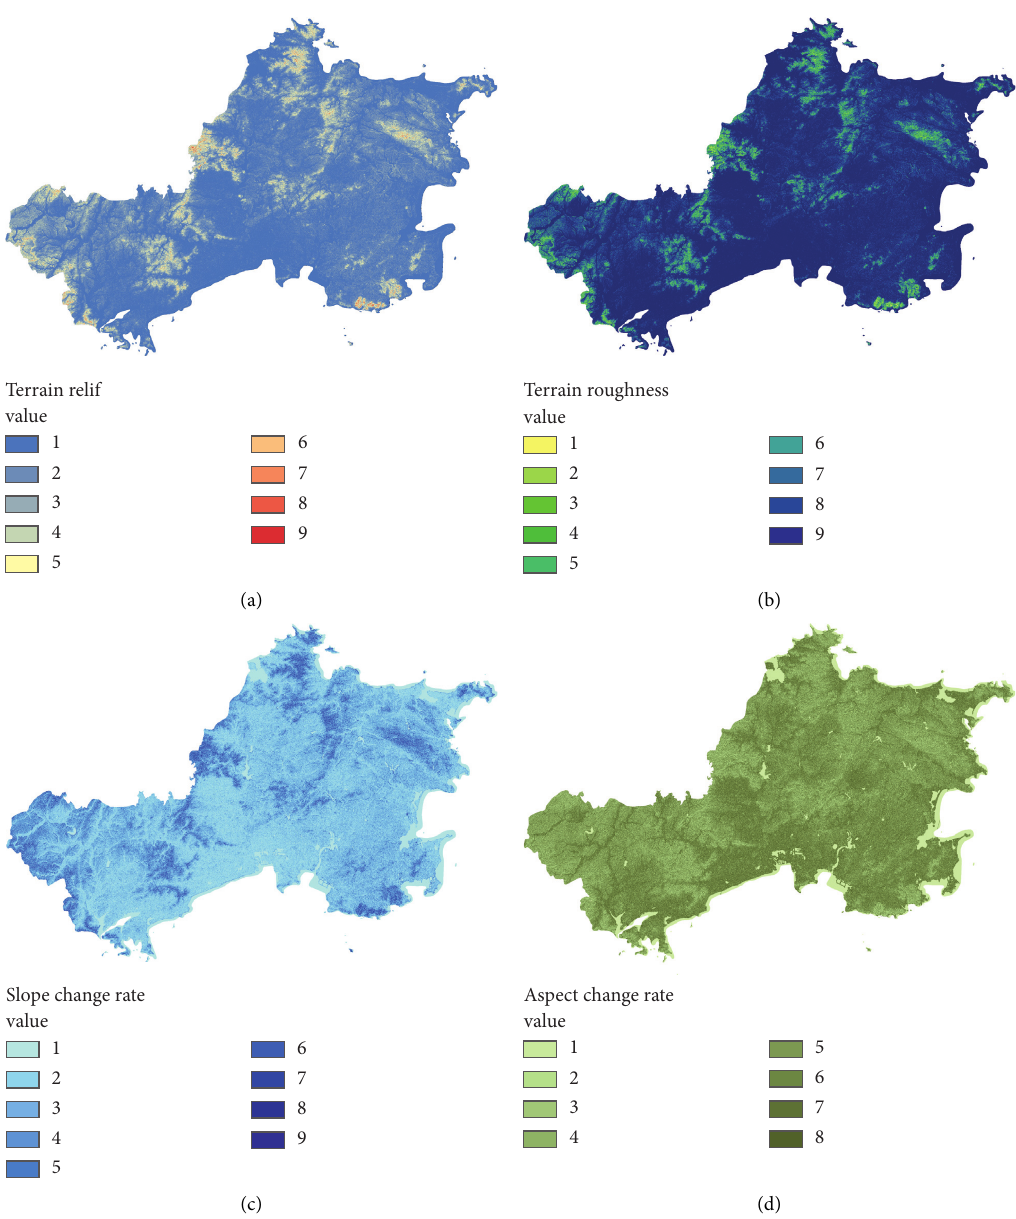
Figure 6: Cost classification map for the four environmental factors: (a) terrain roughness; (b) terrain relief; (c) slope change rate; (d) aspect change